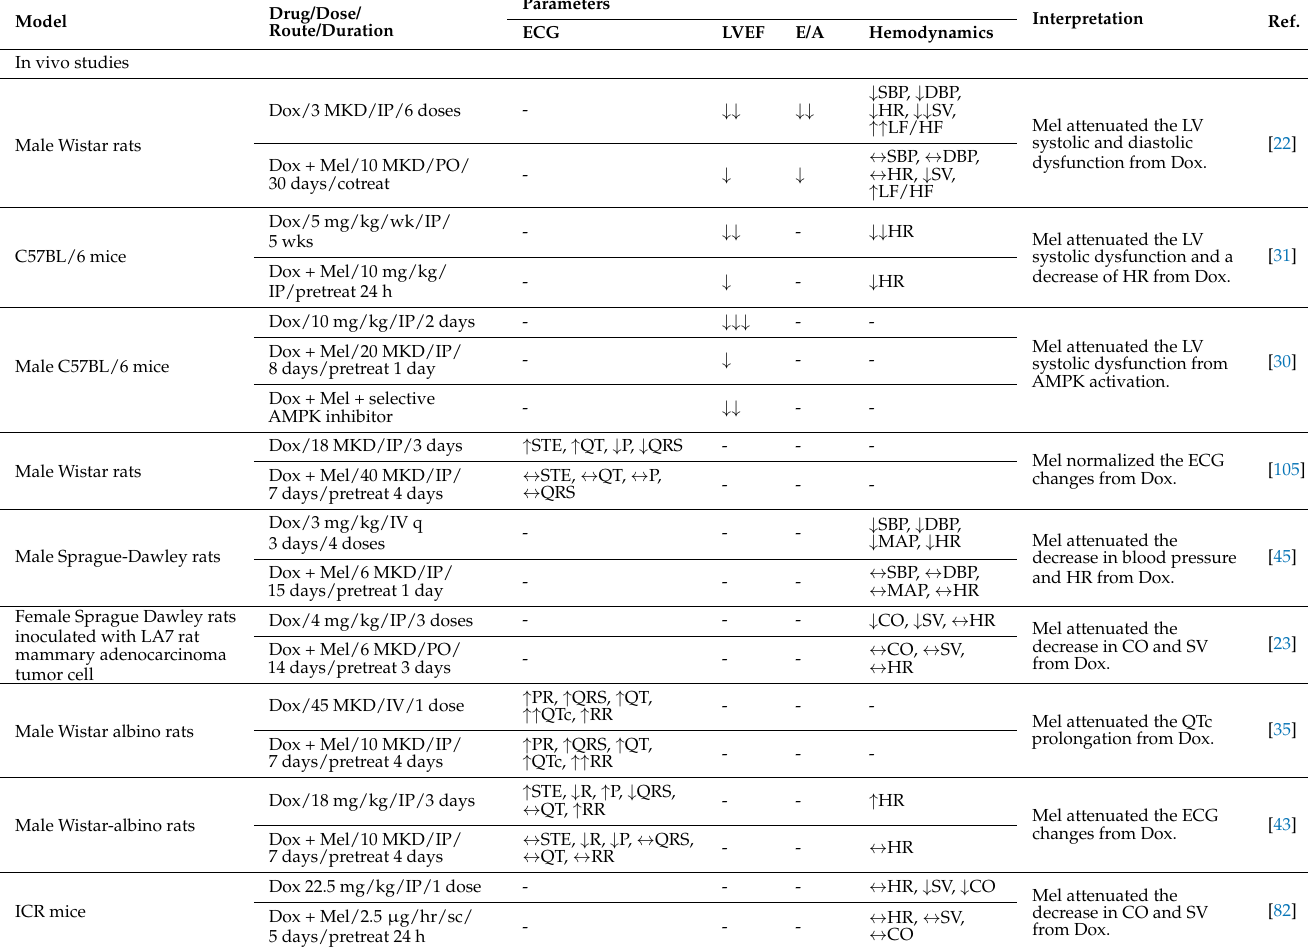
Table 4. Effects of melatonin on ECG, LV function, and hemodynamics in doxorubicin-induced cardiotoxicity: evidence from in vivo and ex vivo